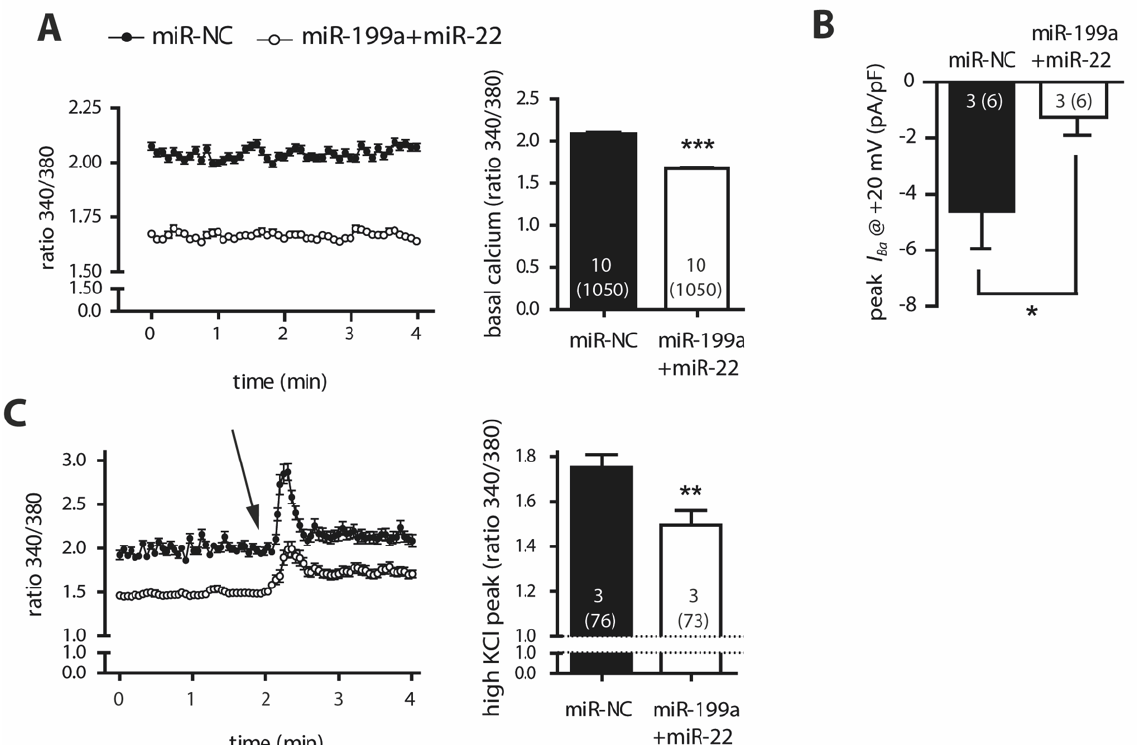
Figure 3. Calcium entrance through LTCC and cytosolic recordings in HL-1 cells transfected with miR-199a+miR-22 (white) or miR-NC (black) ( A ). Left panel, fluctuations of intracellular calcium recorded in basal conditions in cells loaded with Fura-2AM. Right panel, calcium levels graphed and averaged in column bars ( B ). Ba 2+ peak current through Cav1.2 channels at +20 mV recorded using patch-clamp technique in whole-cell configuration ( C ). Left panel, intracellular calcium fluctuations under depolarizing conditions induced by the application of an extracellular solution containing 75 mM KCl (arrow). Right panel, maximum calcium levels graphed and averaged in column bars. * p < 0.05, ** p < 0.005, *** p < 0.0001. Numbers within the columns represent the number of independent experiments performed with the total number of cells analyzed in parenthesis.